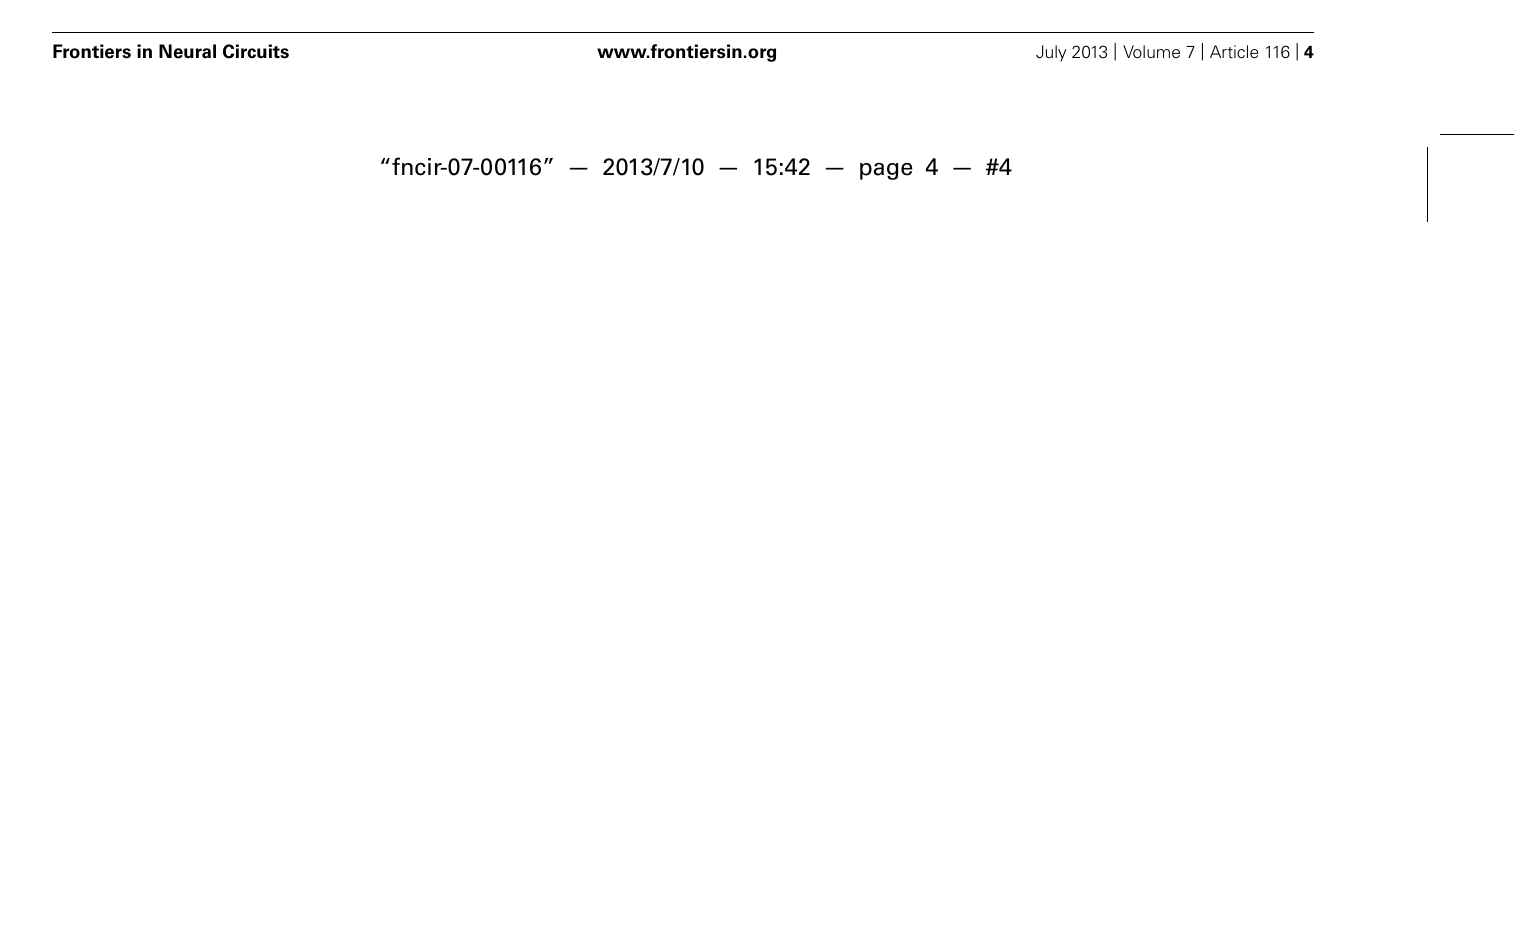
blue line denotes an average of 247 GSPs.Thick green line denotes an example of a "staircase"-like GSP.The thick black line is an example of a GSP with a similar rise time to that of the average GPS. (D) An autocorrelogram of the voltage trace shown in (A) All panels refer to data from the same